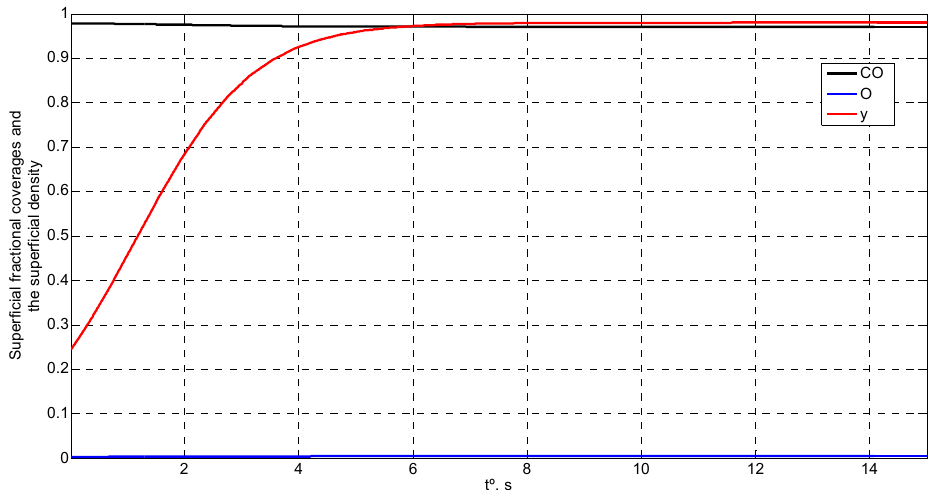
Figure 13. Superficial fractional coverages and the superficial density evolution at P 1 = 213.315 Pa [44].